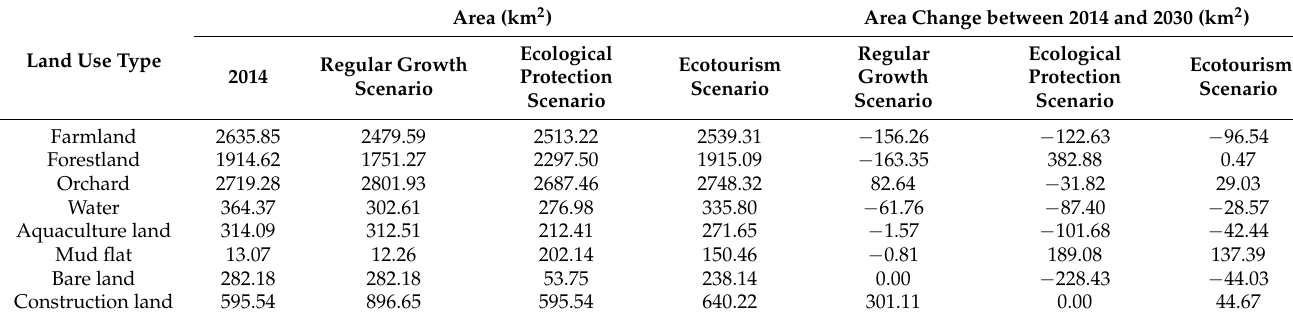
Table 6. Land use area and land use change from 2014 to 2030 for three